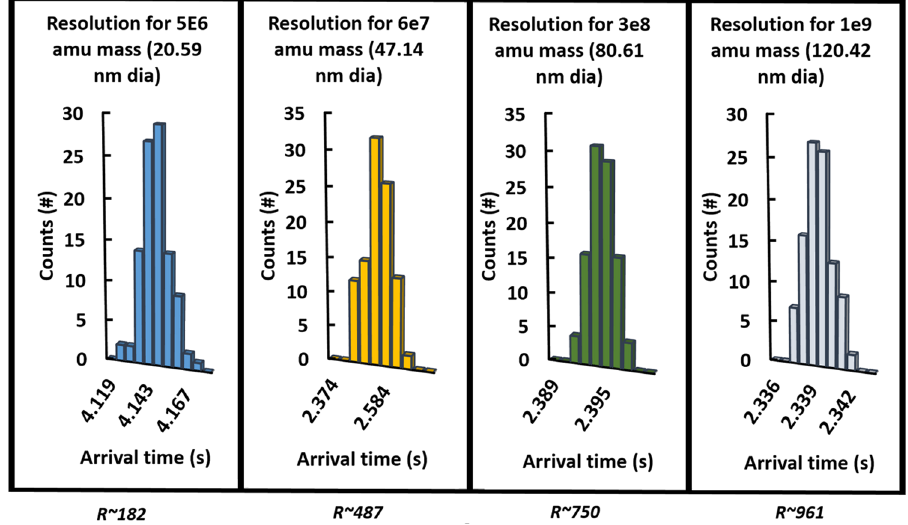
Figure 7. Distributions and Resolution R ~ t / Δ t of simulations using the set of intermittent pushes shown in Fig. 6 for different particles sizes. 100 nanoparticles were used to create the distributions.